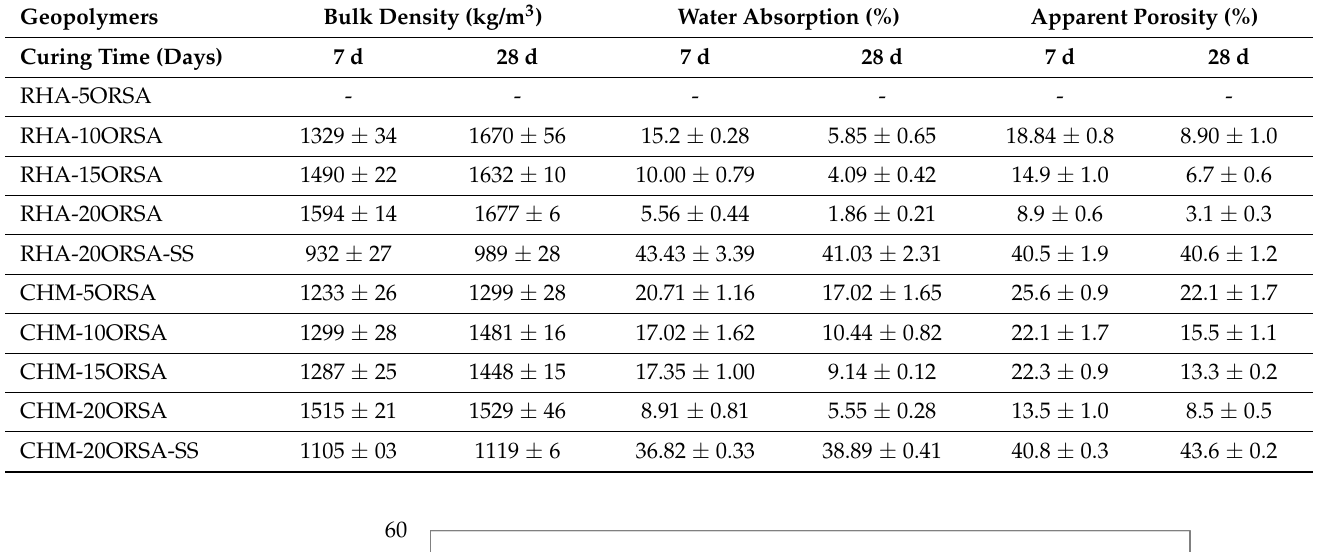
Table 3. Bulk density, water absorption and apparent porosity as function of curing time for the different geopolymers.